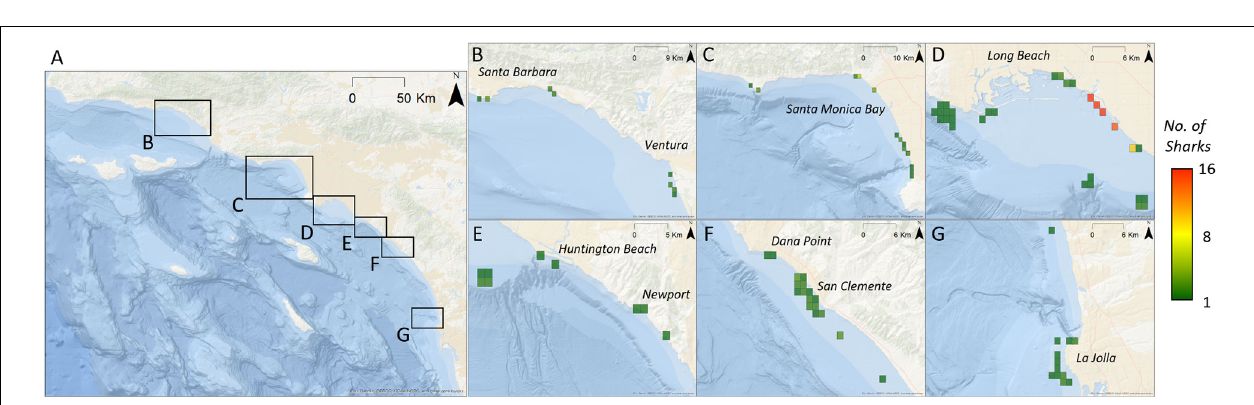
FIGURE 4 | Relative abundance of tagged YOY white sharks (calculated as the total number of sharks per zone per day) across southern California. Regions of importance have been enlarged to view detail. Grid cells are approximately 1.2 km 2 (all years – by location). (A) Base-map of broader study area. Black boxes indicate spatially distinct areas where YOY sharks were detected. (B–G) Indicate location of zones where YOY sharks were detected. Zones are colored according to cumulative relative abundance.